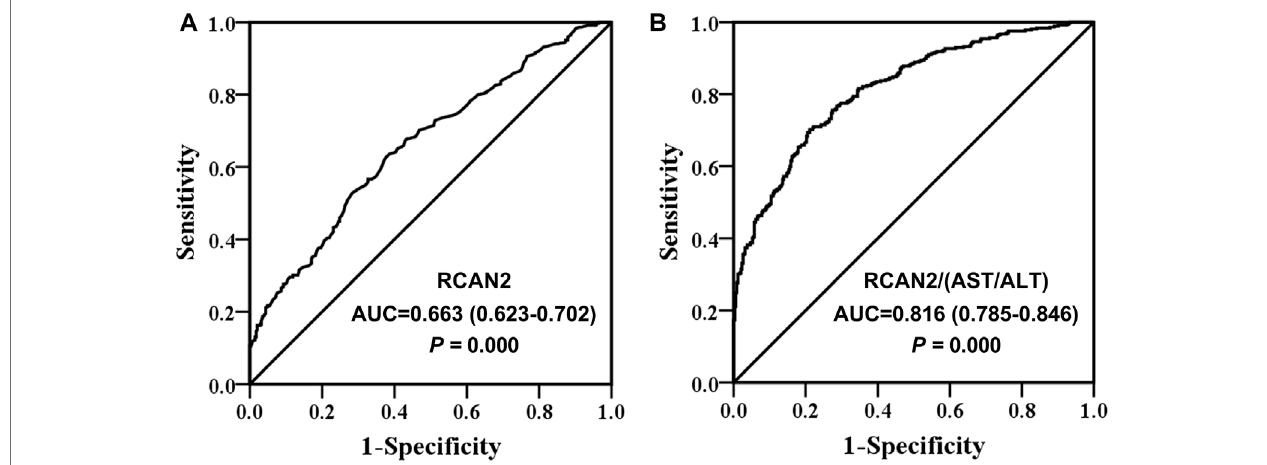
FIGURE 4 | Receiver operating characteristic (ROC) curve analysis of serum RCAN2 levels (A) and serum RCAN2/(AST/ALT) ratio (B) in NAFLD patients and non- NAFLD subjects. NAFLD, non-alcoholic fatty liver disease; RCAN2, regulator of calcium 2; AUC, area under the